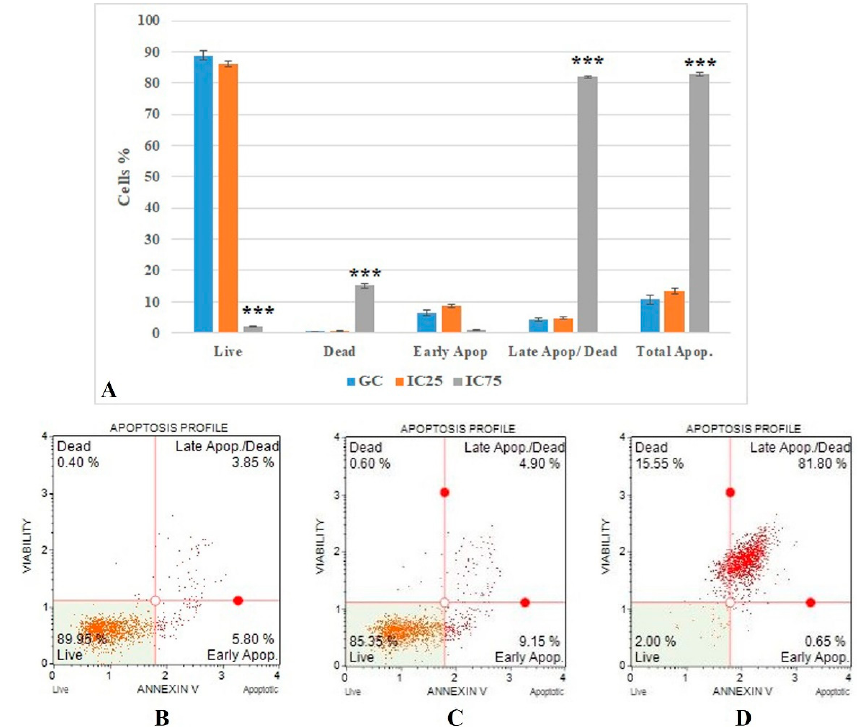
Figure 5. ( A ) Results of cell death mode from Annexin V analysis. GC: growth control; Apop: apoptotic. Data represent the average value of three independent Annexin V analyses. Error bars: the standard deviation of the mean. Asterisk: significantly different from the control (***: p < 0.001). ( B – D ): Sample plots to Annexin V analysis from Muse Cell Analyzer. ( B ) Growth control; ( C ) IC25; ( D ) IC75. The flow cytometric multicaspase results (Figure 6) show the caspase + dead cells value. It was 3.366 ± 0.284 in the growth control group and increased significantly ( p < 0.001) in the Fe ‐ Ni ANPs IC75 concentration (89.483 ± 1.061).